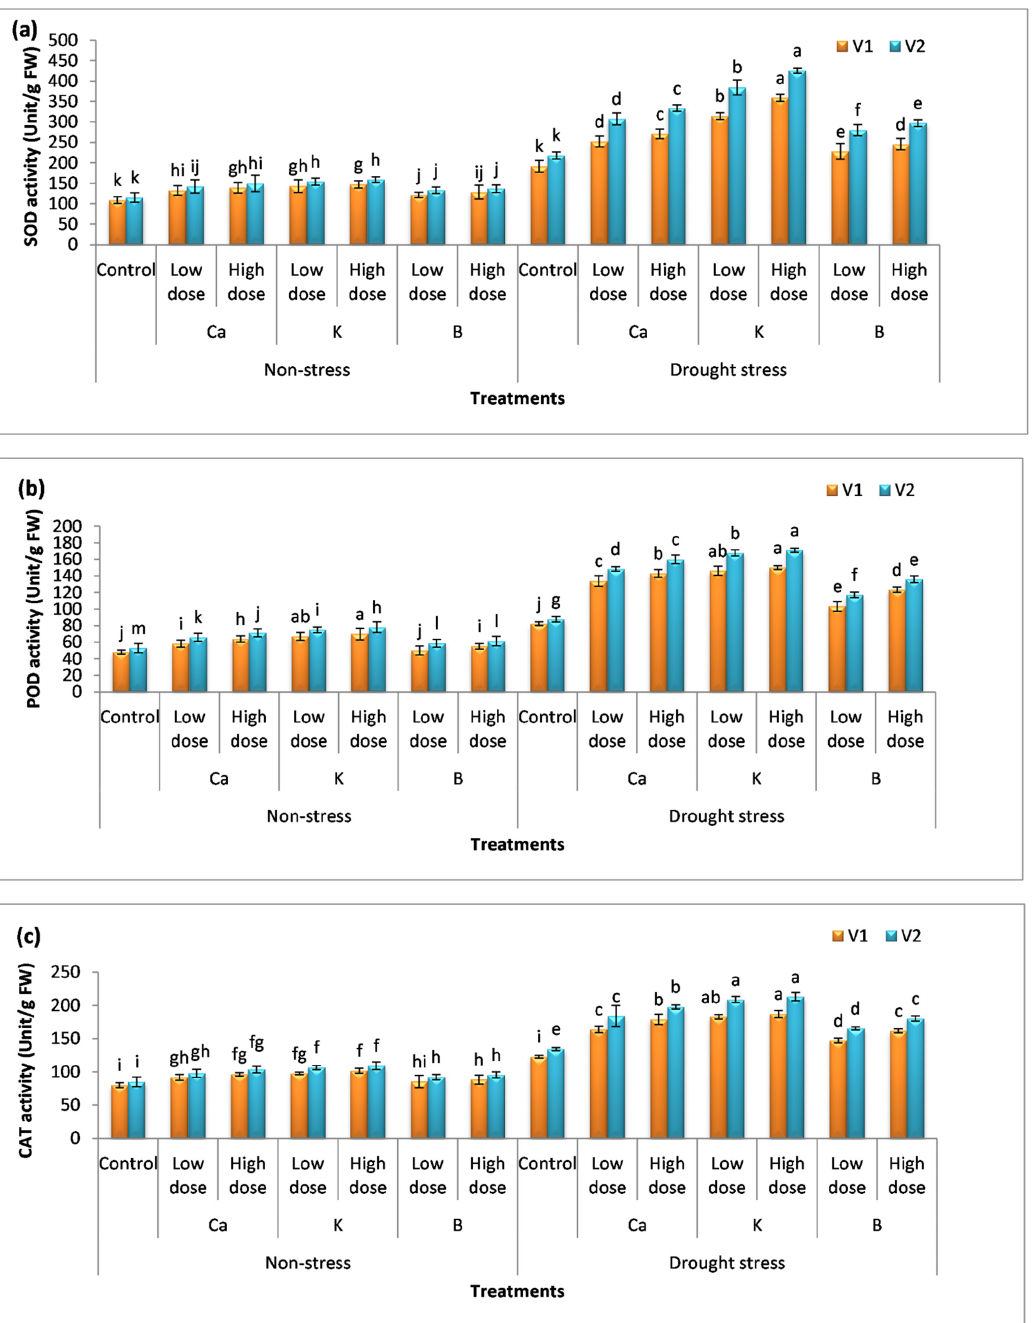
Figure 5. Effect of Ca, K, and B on antioxidant activity of durum wheat. The figures include ( a ) superoxide dismutase activity, ( b ) peroxidase, and ( c ) catalase activity in durum wheat, where V1 = Preco and V2 = Kronos. The different letter shows significant difference among the mean values of